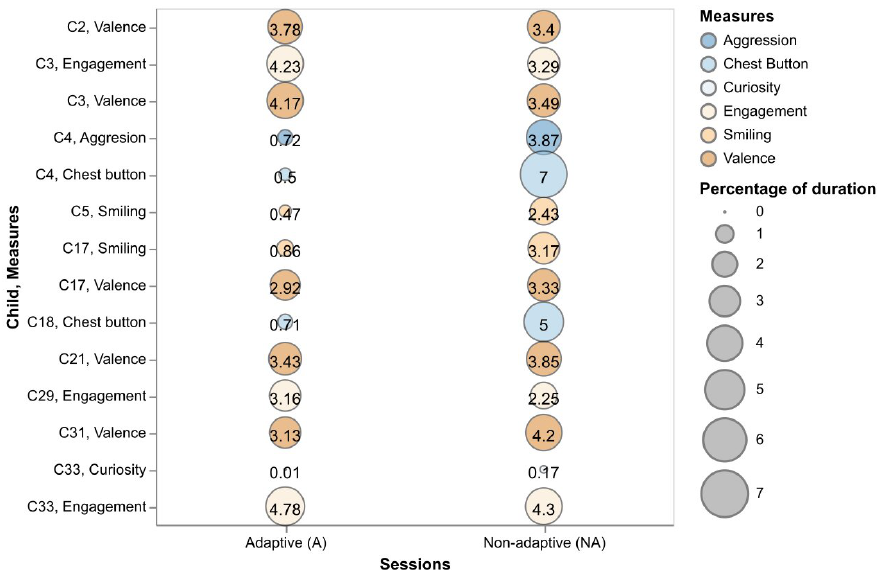
Figure 4. The significant differences of individual analyses across adaptive and non-adaptive sessions. n for p < 0.05.